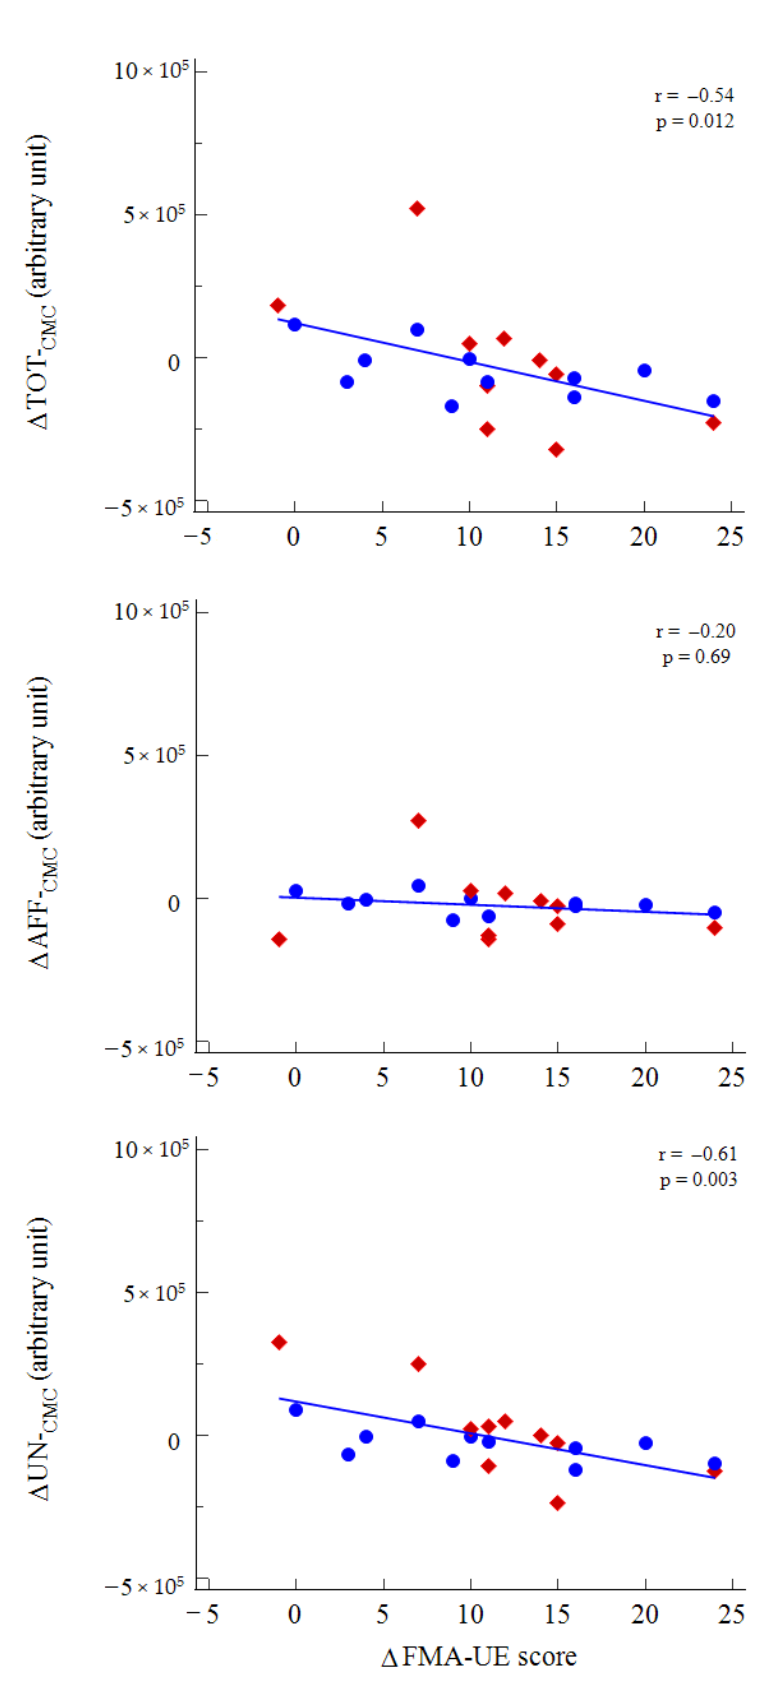
Figure 5. Rank correlation between variations of CMC and variations of FMA-UE score following rehabilitation. Legend: red diamonds, conventional therapy; blue dots, robotic